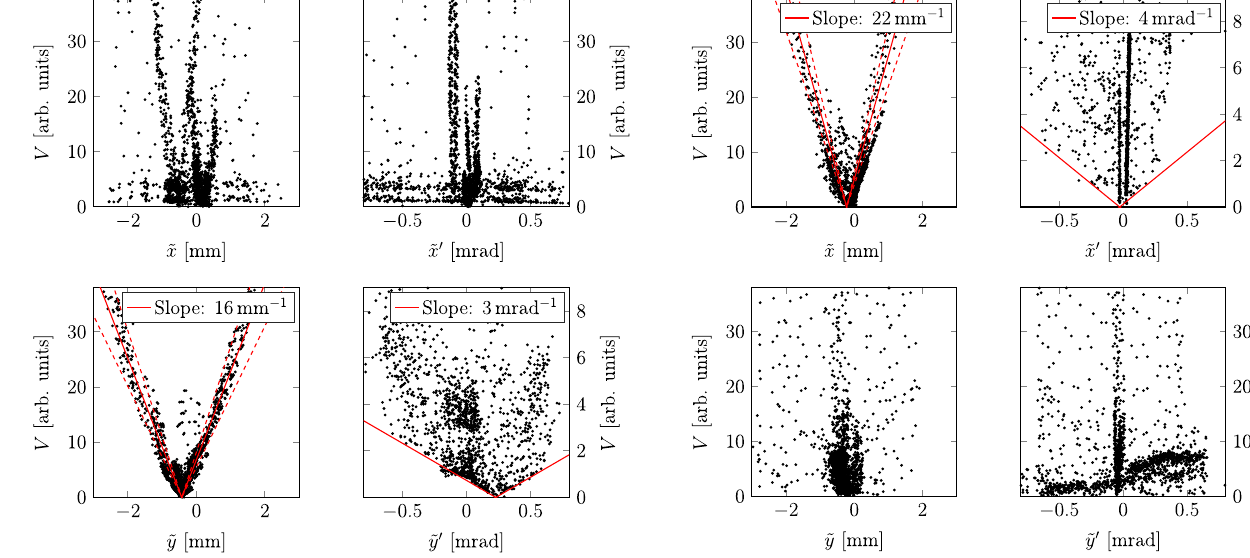
FIG. 11. Normalized amplitude V of the first dipole mode at the downstream coupler at cavity two in ACC2 as a function of the transformed horizontal beam trajectory offset ~ x (upper left), vertical offset ~ y (lower left), horizontal tilt ~ x 0 (upper right), and vertical tilt ~ y 0 (lower right). Note that each data point appears in every